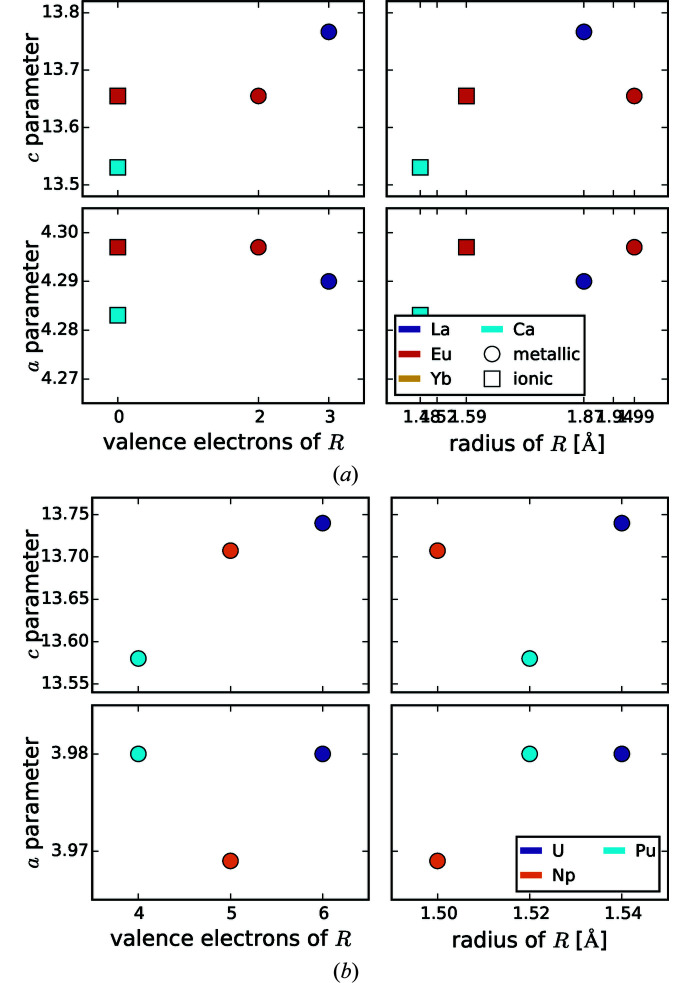
Influence of the valence electron amount on the lattice parameters of ThSi2-like RSi2 and R
2
TSi3 compounds, for R elements with similar radii and constant T element. (a) R
t,1 = Ca, La, Eu, Yb, T = Si and (b) R
t,2 = U, Np, Pu, T = Si.